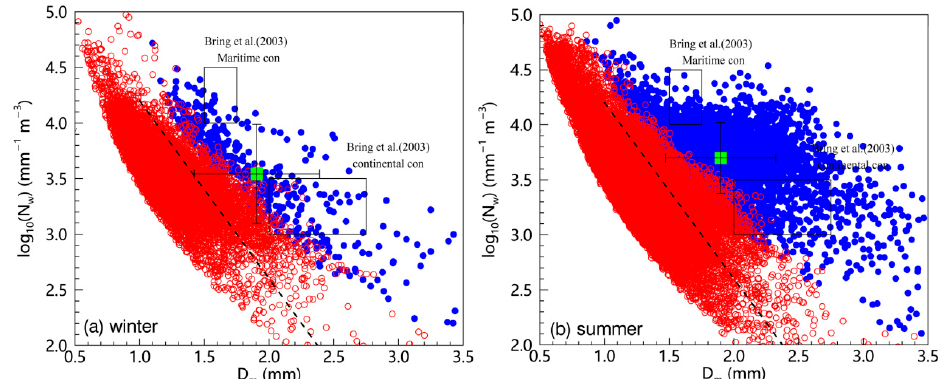
Figure 5. Distribution of log 10 (N w ) and D m observed from the Parsivel disdrometer for convective (blue filled circles) and stratiform precipitation (red hollow circles) during ( a ) winter and ( b ) summer over Jianghuai region (along with ± standard deviation). The green symbol represents the average value of convective rain. The two outlined rectangles correspond to the maritime and continental convective clusters reported by Bringi et al. [48]. The black dashed line indicates the fitting result of stratiform rain [48].